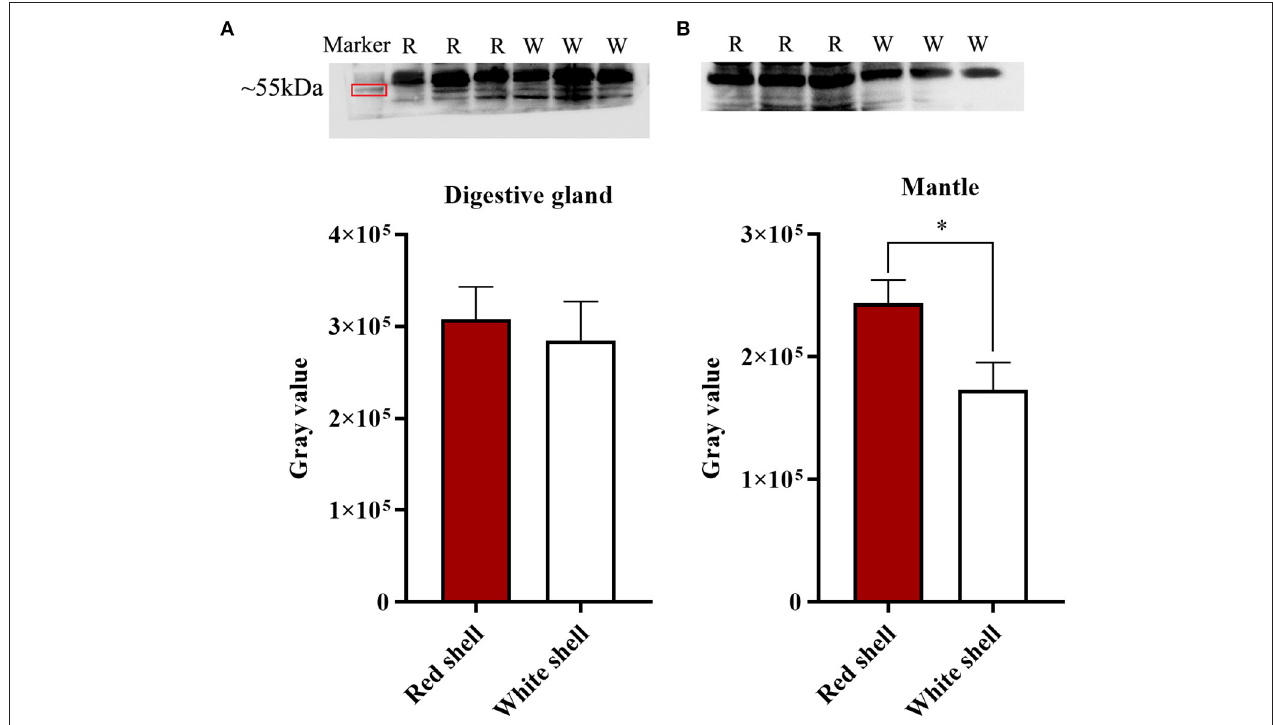
FIGURE 5 | Western blotting analysis of Mm-BCDO2 protein in the digestive gland (A) and mantle (B) of red and white shell clams. Significant differences between red shell and white shell are indicated with an asterisk for P <